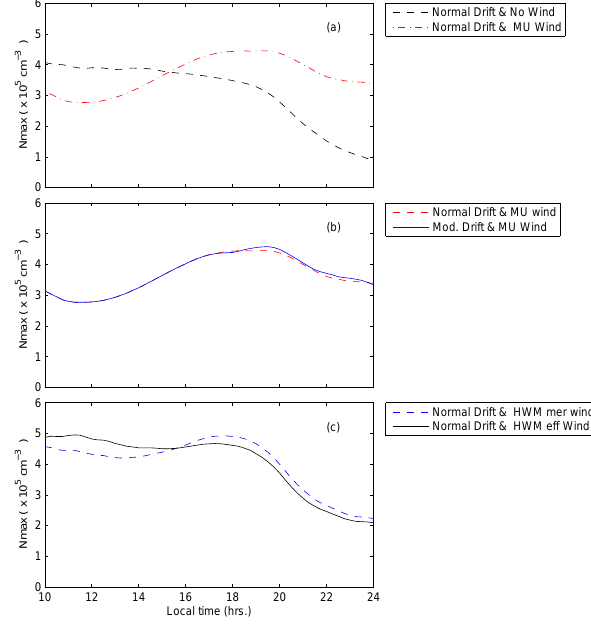
Fig. 6. Model inputs. (a) Local time variation of the two drift pat- terns used for the simulations. (b) Local time variation of MU radar derived winds and HWM-93 meriodional winds outputs used for simulations. (c) The local time variation of zonal ( U ), meridional ( V ) and effective winds obtained from the HWM-93 model, corre- sponding to 38 ◦ N magnetic latitude.